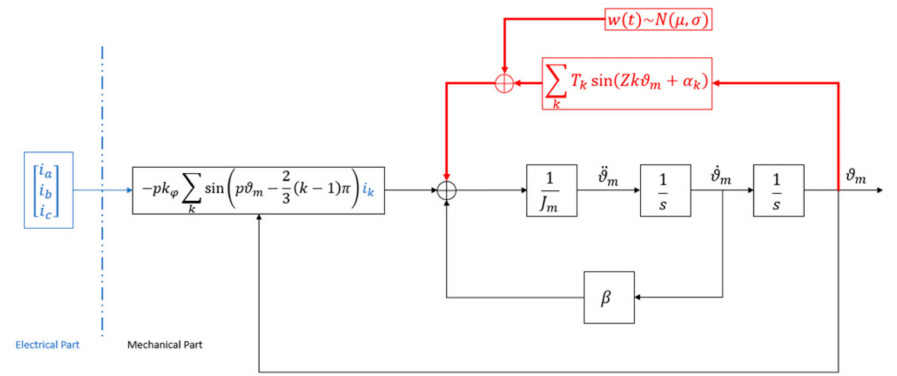
Figure 8. Model of the cogging torque (in the red box) inserted into the mechanical di ff erential equations of the motor.